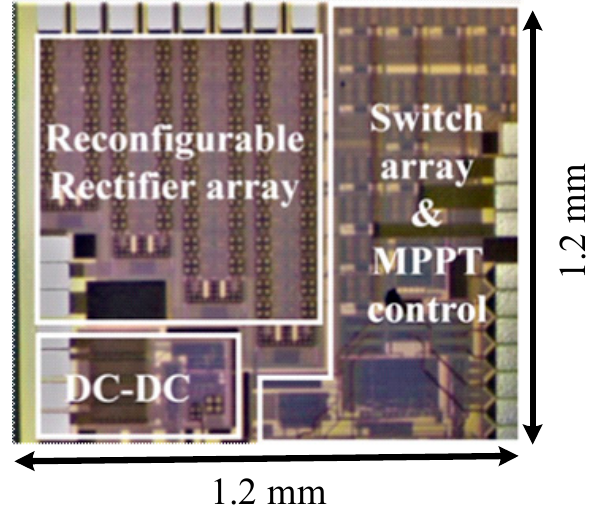
Figure 8. Chip micro photograph.